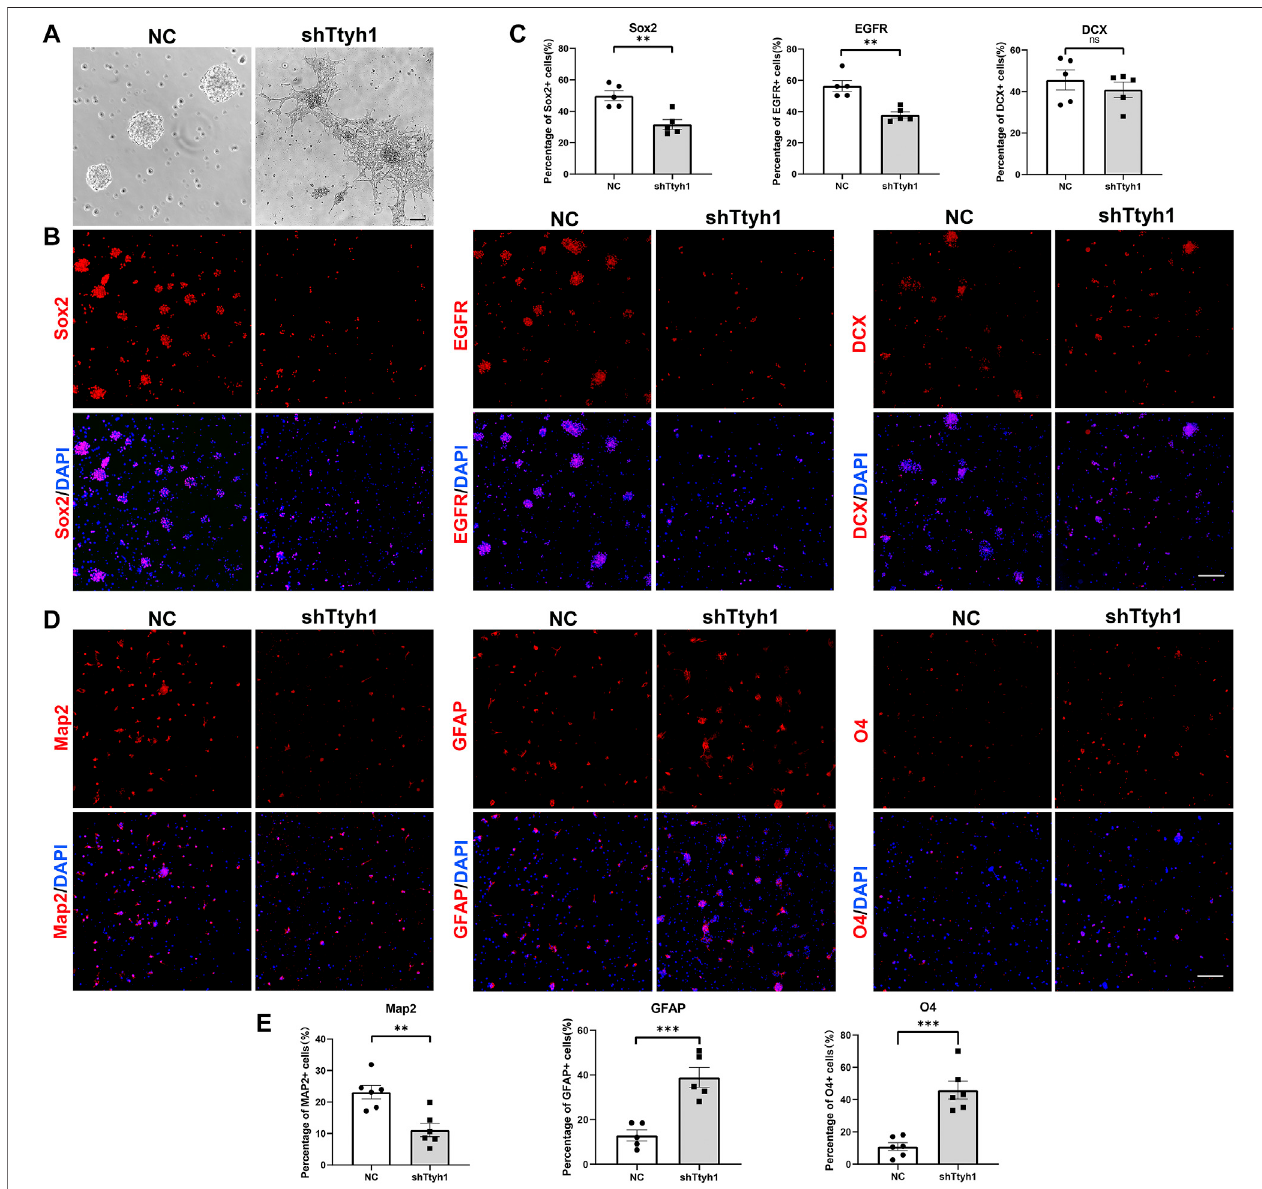
FIGURE 3 | Ttyh1 maintains the stemness of NSCs in vitro . (A) Bright fi eld microscopy showed the morphological disparity between NSCs transfected with negative controlshRNA(NC)andshTtyh1.Weadded NCand shTtyh1containinglentivirusesrespectivelyonprimaryculturedNSCs.After48 hoftransfection,thecellsinthecontrol group aggregatedtoformneurospheresandgrewinsuspension,whilethecellsintheshTtyh1group protruded neuritesand adheredtotheplate. (B) Immuno fl uorescence staining of NSCs after transfection. After 72 h of transfection, the NSCs were collected and resuspended into single cell suspensions, plated on cover glass and incubated for24 h,and thensubjected toimmuno fl uorescencestaining. Comparedwiththecontrolgroup,theproportions ofSox2 + cells (left) and EGFR + cells (middle) in the shTtyh1 group were signi fi cantly reduced, whereas DCX + cells (right) were not signi fi cantly changed. (C) Statistics of the percentages of immunopositive cells in B. (D) Immuno fl uorescence staining of differentiated neural cell markers. Compared with the control group, the proportions of GFAP + and O4 + cells were increased, whereas the proportion of Map2 + cells were decreased. (E) Statistics of the percentages of immunopositive cells in D. Scale bar (cid:2) 50 μ m in A, Scale bar (cid:2) 200 μ m in B, D. n (cid:2) 5 for all experiments. Data are expressed as mean ± SEM. Statistical signi fi cance was calculated using an unpaired, two-tailed Student ’ s t -test. ( ppp ) p < 0.001, ( pp ) p < 0.01.